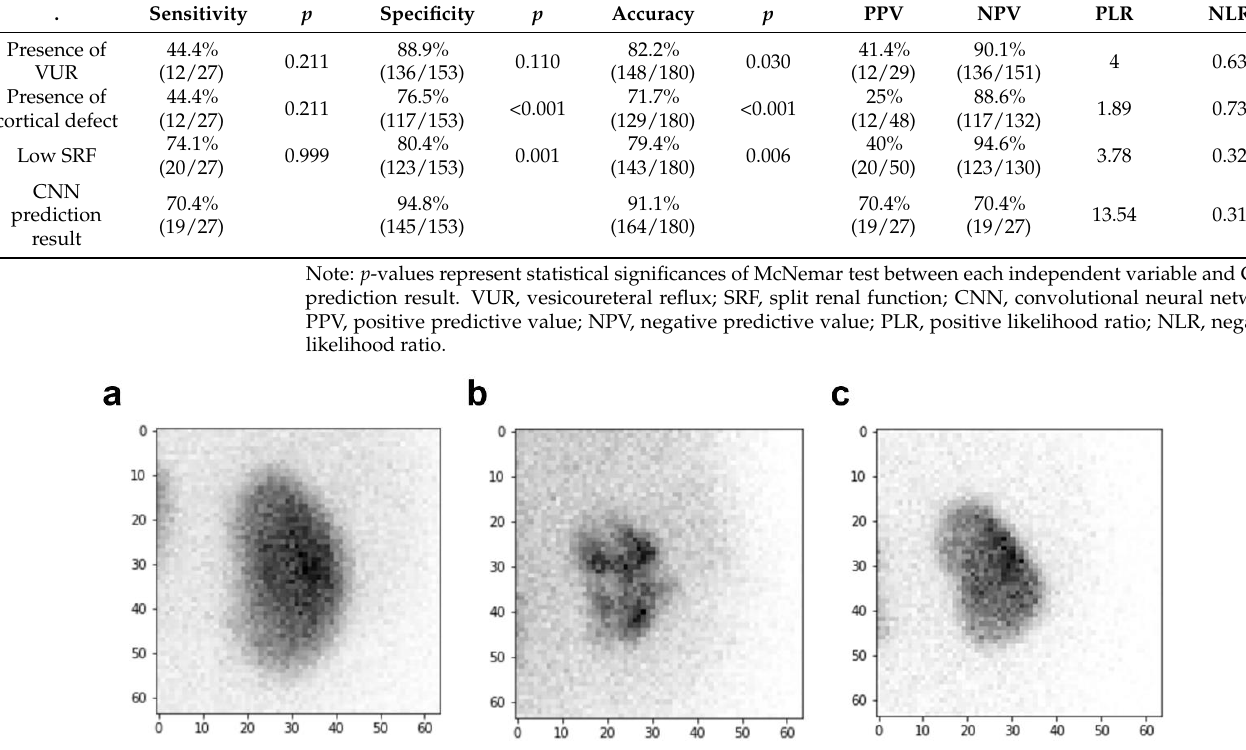
Figure 2. Representative cases of 99m Tc-DMSA renal scan. ( a ) A case without demonstrable abnor- ity in 99m Tc-DMSA renal scan and without recurrent UTI. It was classified as a case without recurrent